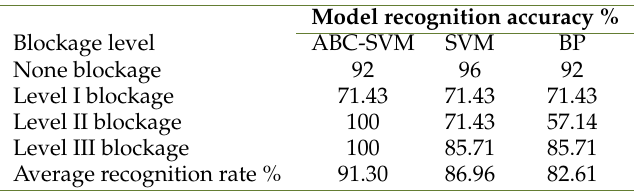
Table 2. Comparison of classification effects of different recognition